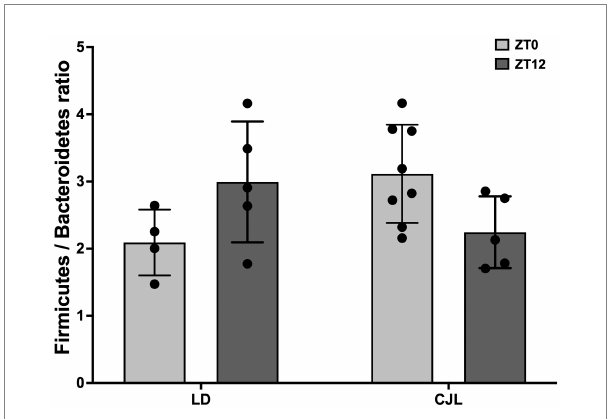
FIGURE 4 Daily changes in gut microbiota (Firmicutes/Bacteroidetes ratio) composition for mice under LD and JCL at ZT0 and ZT12. Two-Way ANOVA, p = 0.0102, F = 8.235 for interaction; p = 0.6646, F = 0.1943 for light schedule; p = 0.9592, F = 0.0026 for ZT; followed by Tukey’s multiple comparisons test: ns; n =